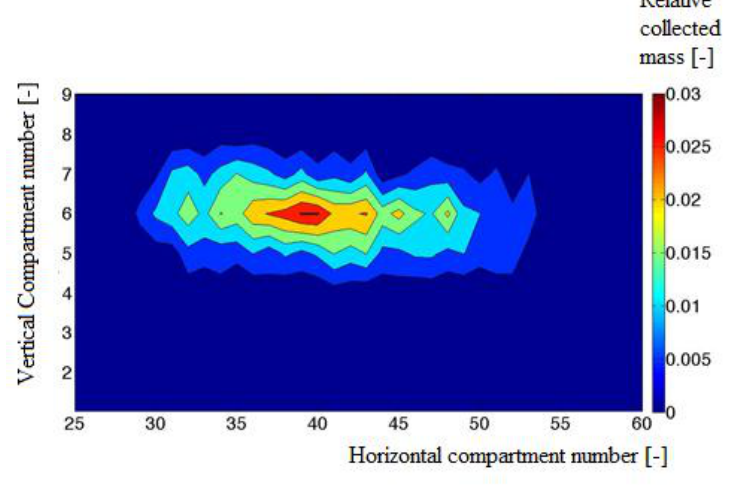
Figure 9. Experimentally determined cylindrical fertilizer distribution.